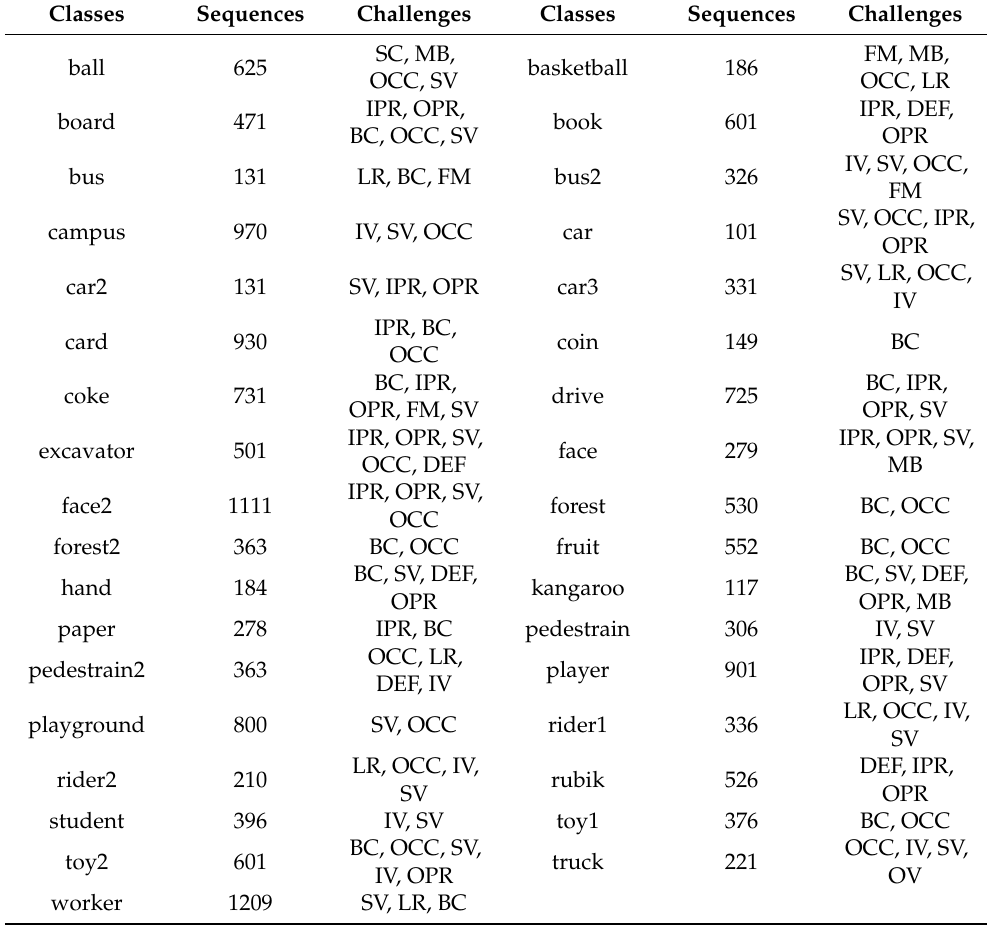
Table 1. IMEC16 Dataset Statistic Analysis for Close-range Object